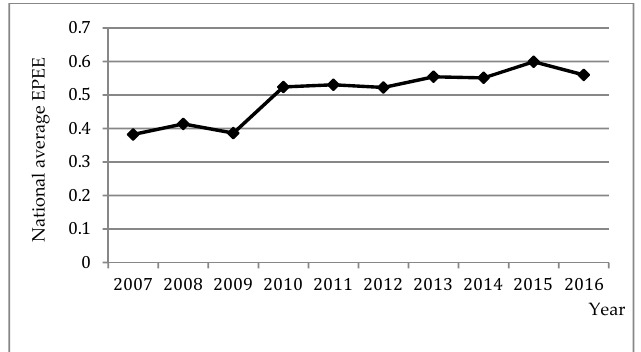
Figure 2. The trend of the national average EPEE from 2007 to 2016.